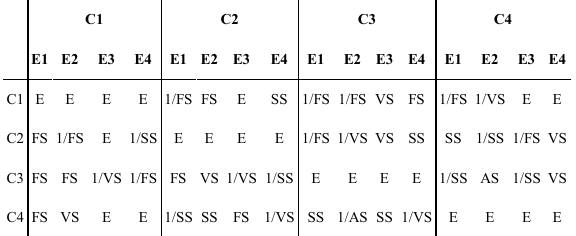
Table 5: Expert Evaluations of main criteria with respect to the goal